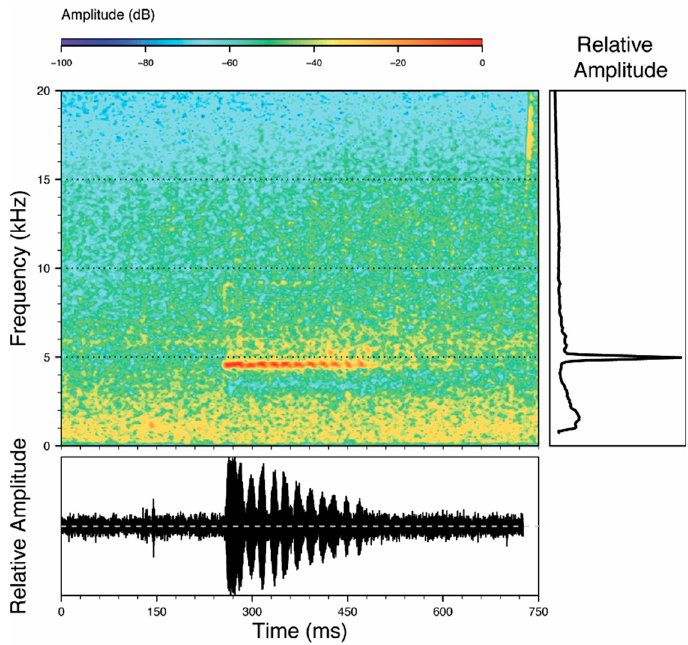
Figure 107. Call of Hyalinobatrachium chirripoi recorded at Reserva Itapoa, 321 m, Esmeraldas province, Ecuador, LBE-C-019.